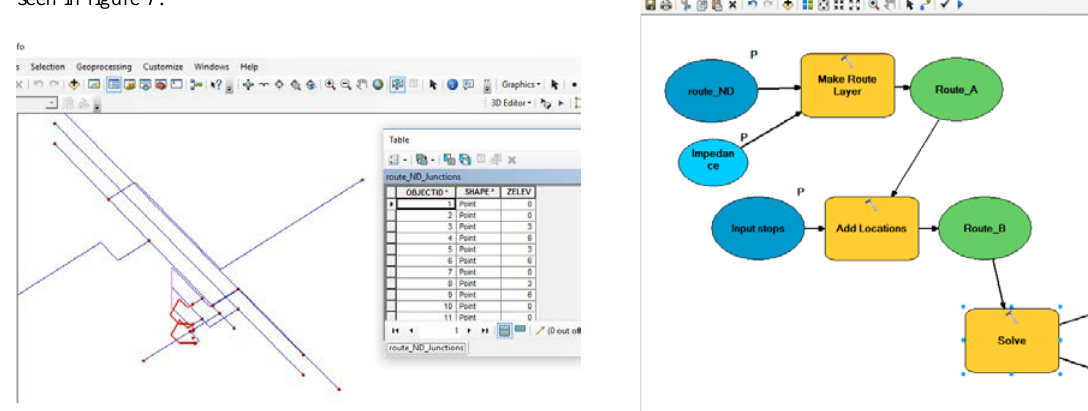
Figure 7. Network junction points